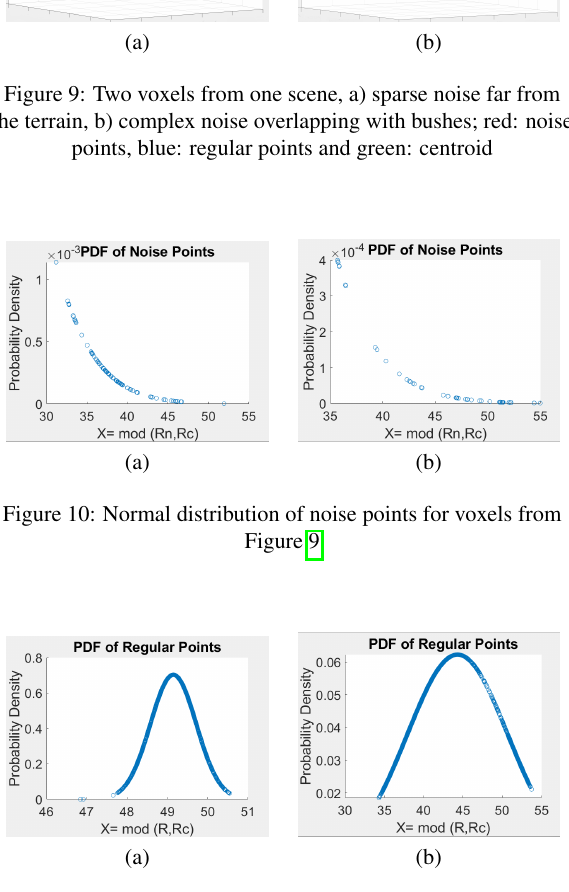
Figure 11: Normal Distribution of regular points for voxels from Figure 9